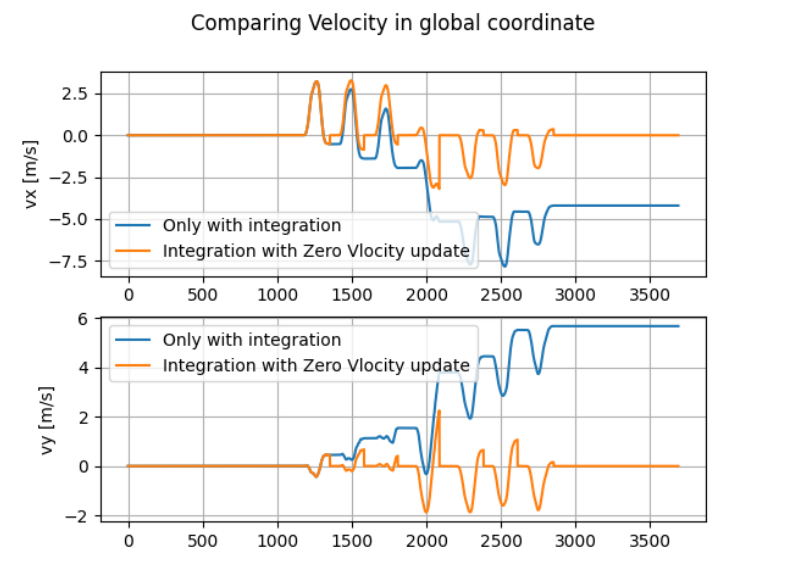
Figure 6. Comparison between the velocity obtained by only integration and the velocity obtained by the Zero Velocity Update and integration (the horizontal axes and vertical axes denote the index and velocity [m/s],